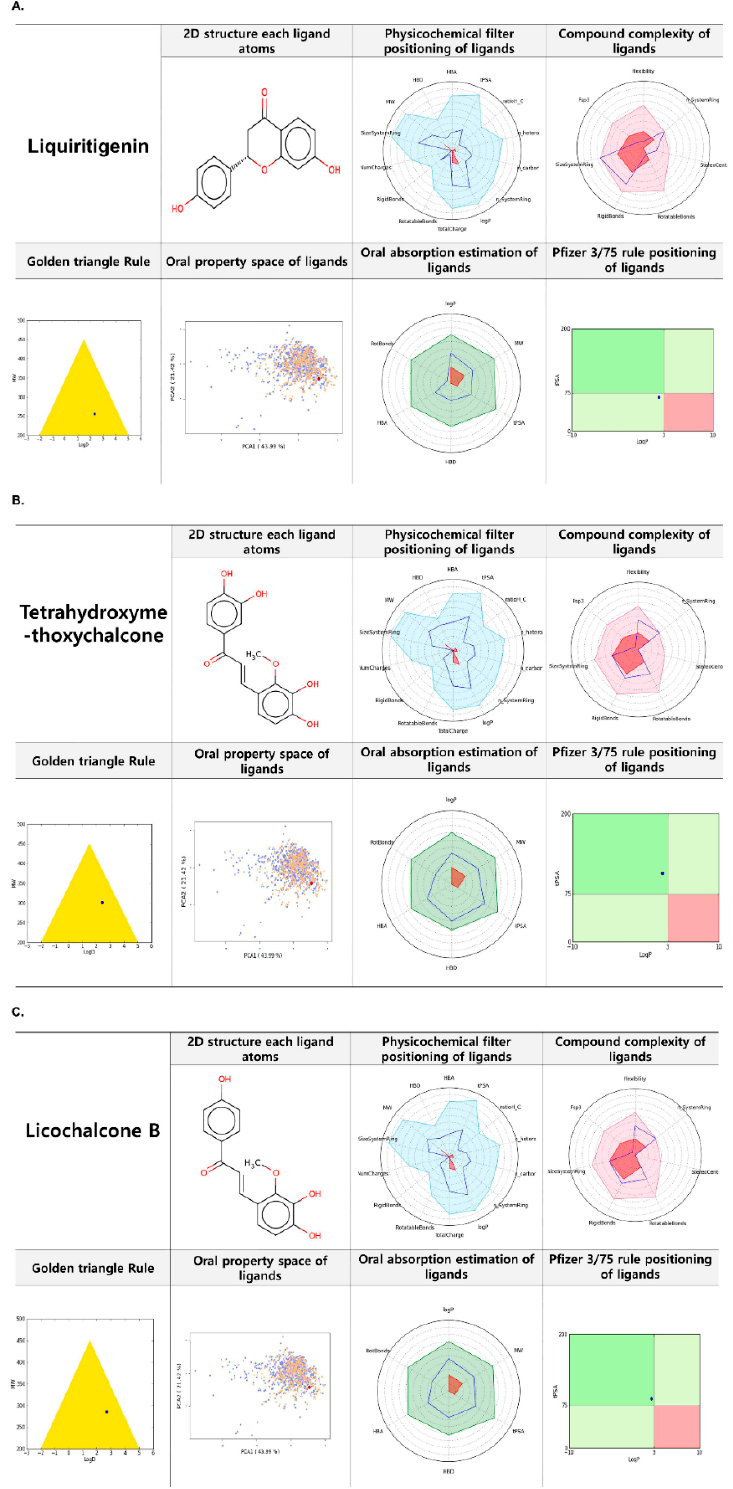
Figure 7. FAF-Drugs4 results for the Top 3 compounds and their respective ADME properties. ( A ) liquiritigenin, ( B ) tetrahydroxymethoxychalcone, ( C ) licochalcone B.